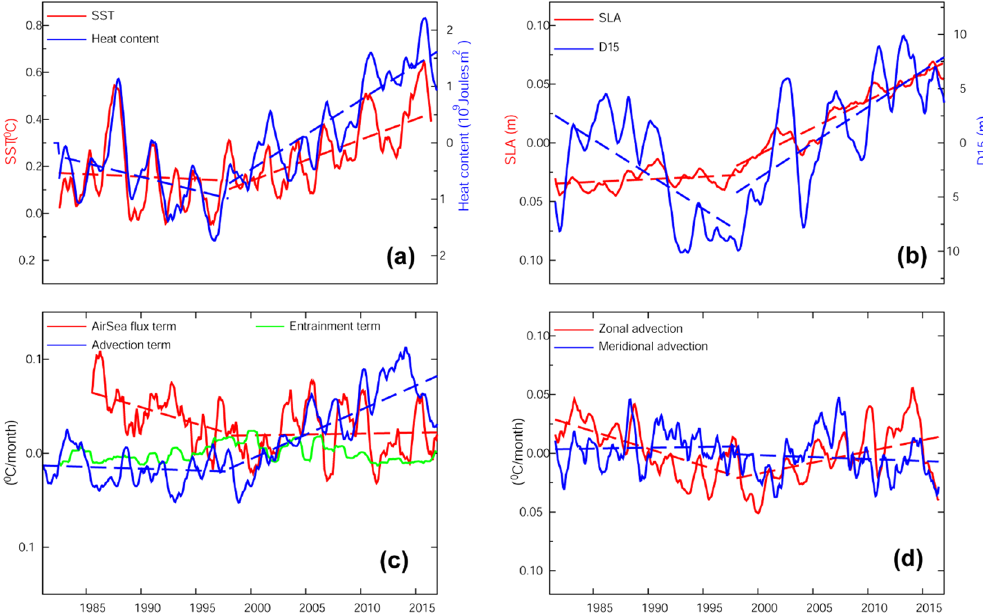
Figure 2. Monthly mean anomalies of ( a ) SST (red) and heat content (blue), ( b ) sea level (red), ( c ) mixed layer budget terms (Air-sea flux term - red, Advection term- blue, Entrainment term – green), ( d ) zonal (red) and meridional (blue) component of the advection term in the Mascarene High region [20°S–40°S & 45°E–100°E]. The dashed lines represent the trend line. All trends are significant above a 95% confidence